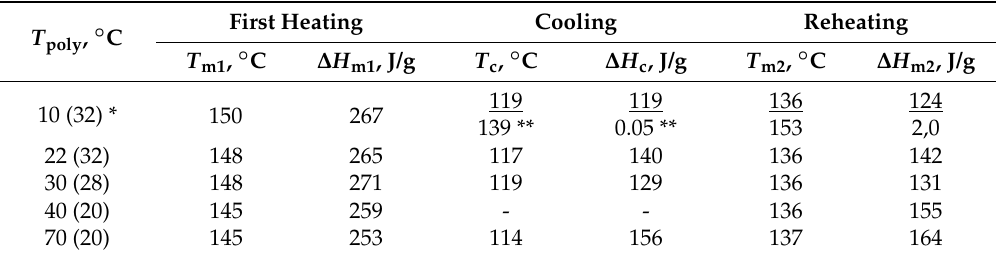
Table 4. DSC data of oriented film